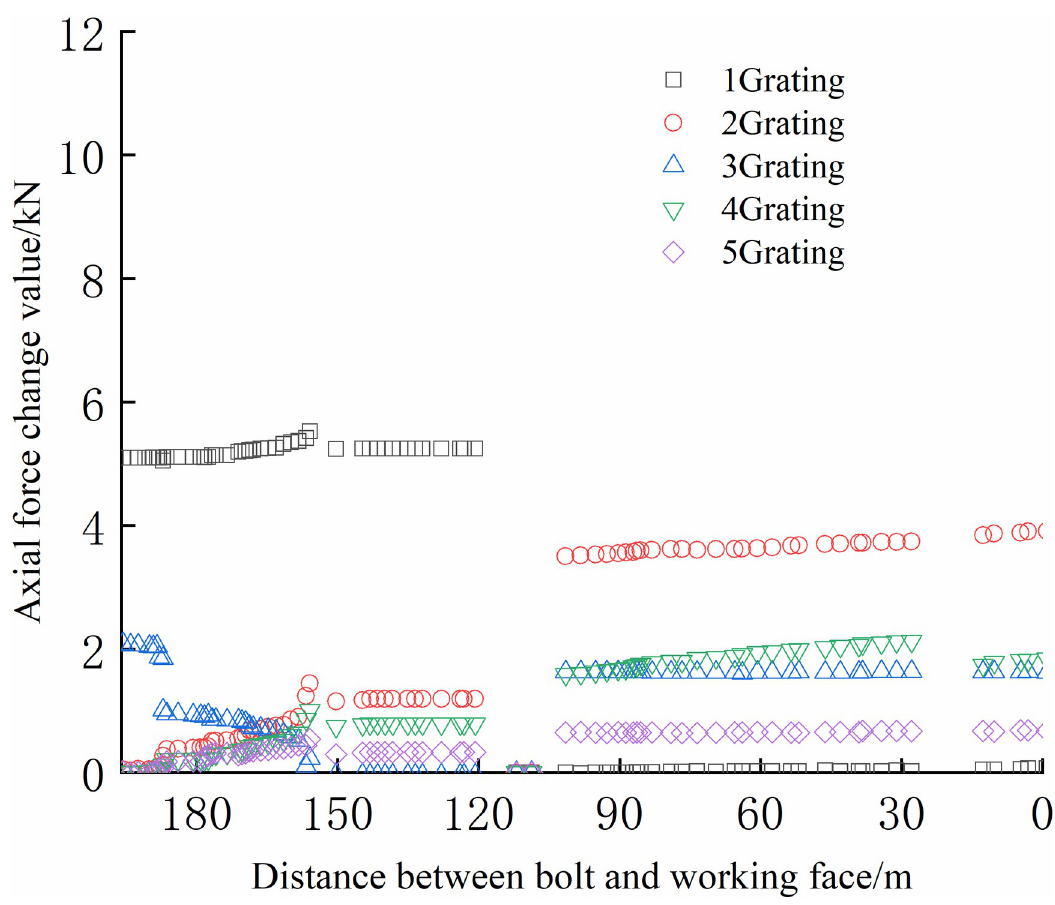
Fig 30. Axial force monitoring test curve of No. 7 bolt.